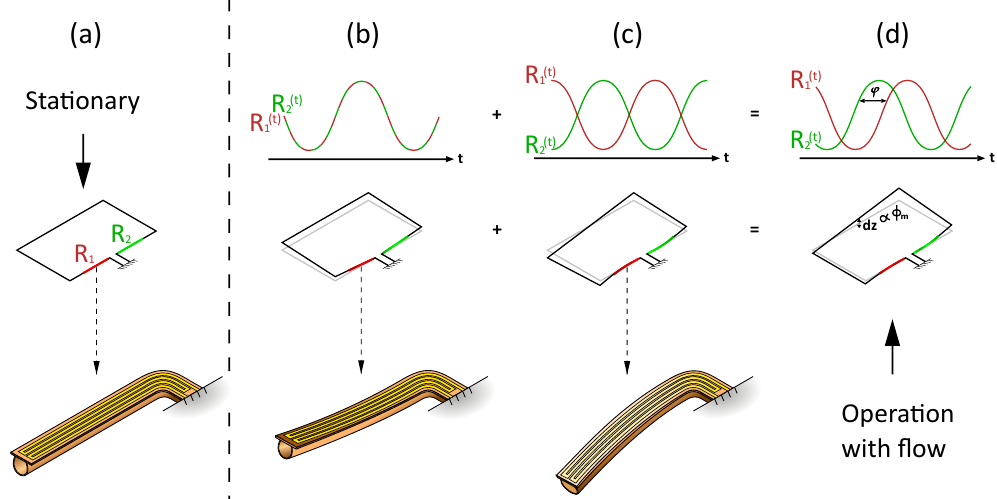
Figure 5. Principle of operation of the resistive readout. ( a ) configuration of the strain gauges in rest. ( b ) In the Swing mode, both strain gauges will be compressed. This results in equal resistance change. ( c ) In the Twist mode, one strain gauge is elongated, the other will be compressed. This results in opposite change in resistance. ( d ) Combination of the two modes gives two resistance signals with a phase shift dependent on the mass flow